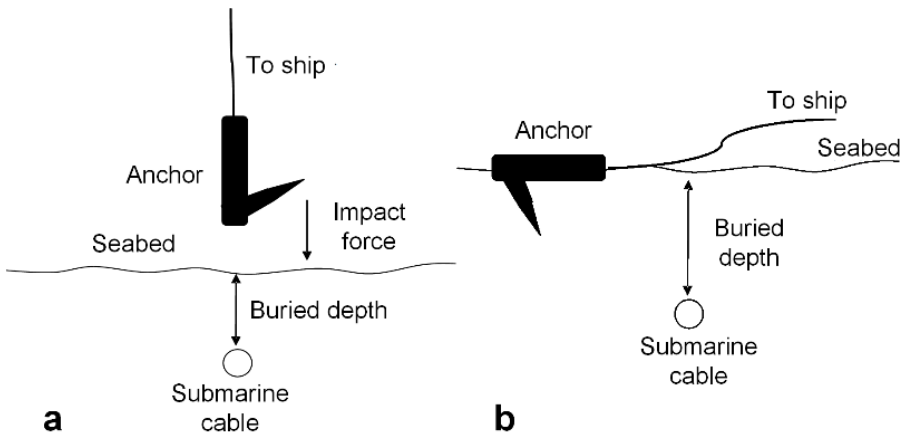
Figure 1. The impact and drag damage on submarine cables. ( a ) Impact damage on submarine cable; ( b ) Drag damage on submarine cable.